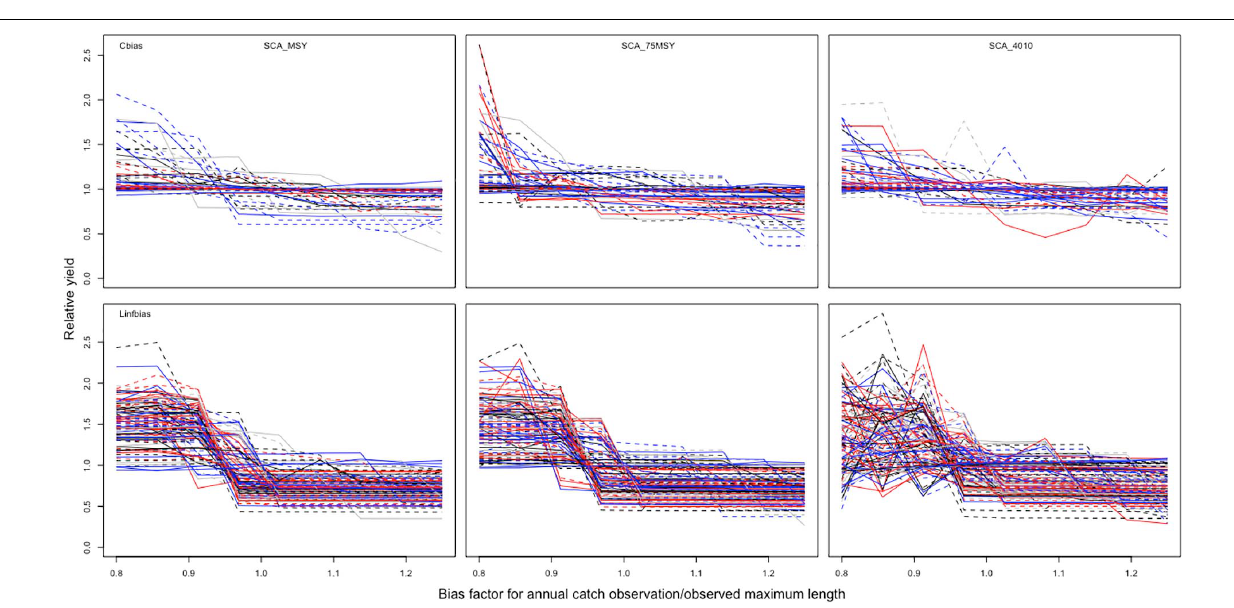
FIGURE 3 | Results of 128 simulations of the parameters Cbias and Linfbias with three